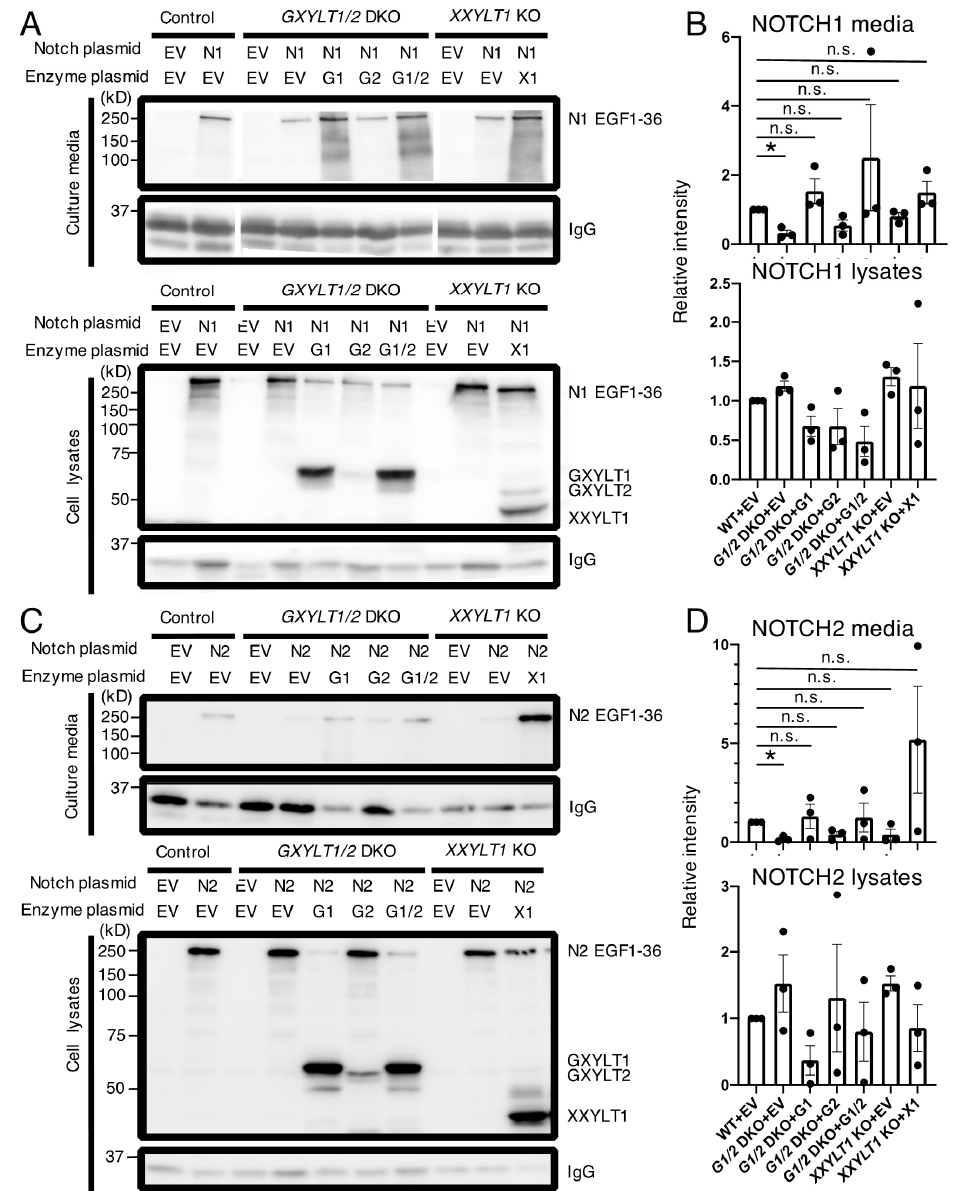
Figure 6. Xylosyl extension of O -Glc glycans enhances the secretion of the ECDs of NOTCH1 and NOTCH2 overexpressed in HEK293T cells. ( A ) Secretion assay with the Myc-His 6 -tagged version of EGF1–36 of NOTCH1 (N1 EGF1–36) in the wild type control and XYLTs ’ KO clones. The N1 EGF1–36 proteins in the culture media and the cell lysates were detected by Western blotting using an anti-Myc antibody. EV, empty vector; N1, NOTCH1; G1, GXYLT1; G2; GXYLT2, X1; XXYLT1. A representative image of three independent experiments is shown. ( B ) The relative intensities of the N1 EGF1–36 proteins are indicated. Plots are from three independent experiments ( n = 3). Bar graphs show the average ± SEM. * p < 0.05; n.s., not significant. ( C ) Secretion assay with the Myc-His 6 -tagged version of EGF1–36 of NOTCH2 (N2 EGF1–36) in the wild type control and XYLTs ’ KO clones. N2 EGF1–36 proteins in the culture media and cell lysates were detected by Western blotting using an anti-Myc antibody. EV, empty vector; N1, NOTCH1; G1, GXYLT1; G2; GXYLT2, X1; XXYLT1. A representative image of three independent experiments is shown. ( D ) The relative intensities of the N2 EGF1–36 proteins are indicated. Plots are from three independent experiments ( n = 3). Bar graphs show the average ± SEM. The raw data are available in Figure S8. *, p < 0.05; n.s., not significant ( p ≥